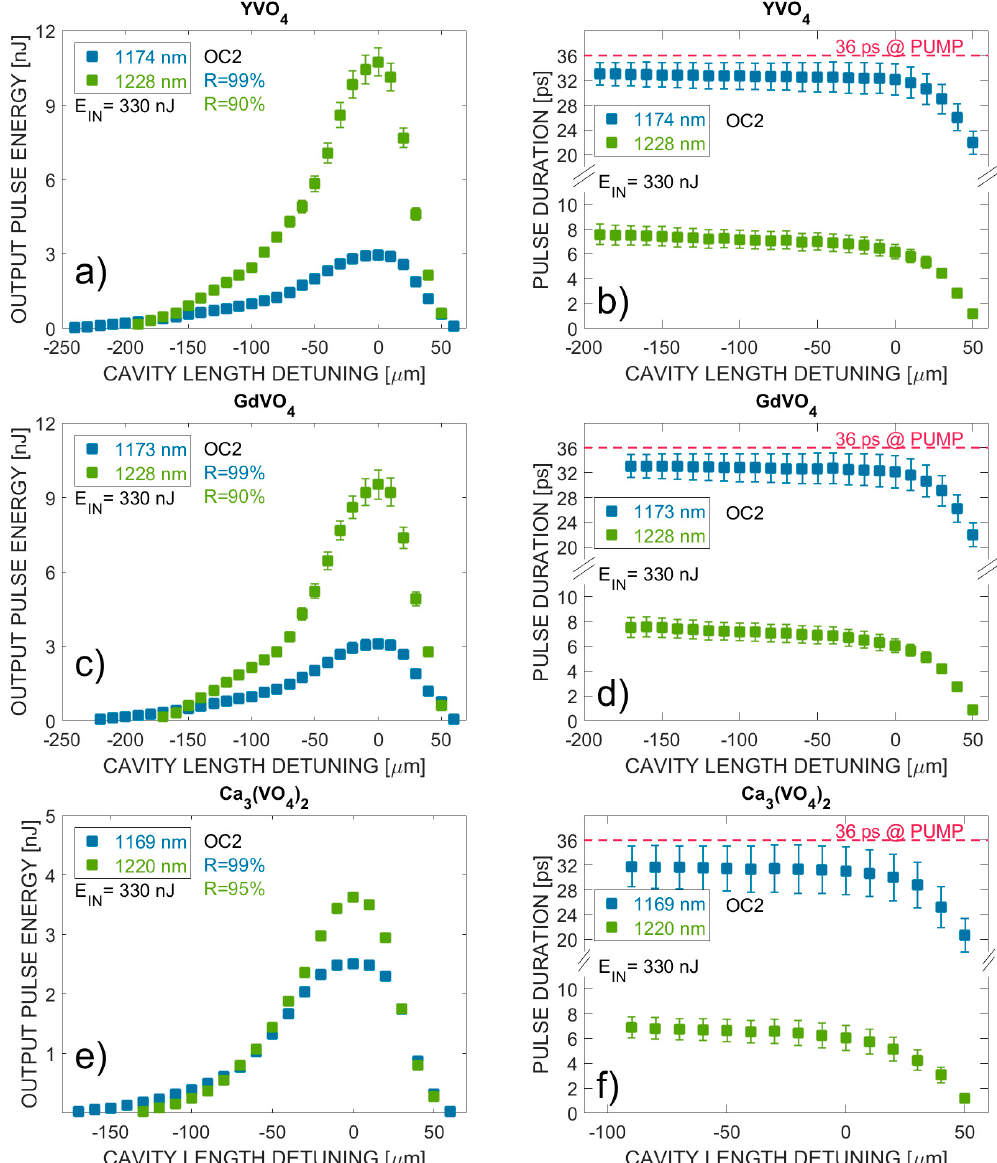
Figure 6. Dependencies of ( a , c , e ) the output pulse energy and ( b , d , f ) the output pulse duration on the cavity length detuning for the ( a , b ) YVO 4 , ( c , d ) GdVO 4 , and ( e , f ) Ca 3 (VO 4 ) 2 Raman laser with the output coupler OC2 under pumping with the maximal pulse energy of 330 nJ.